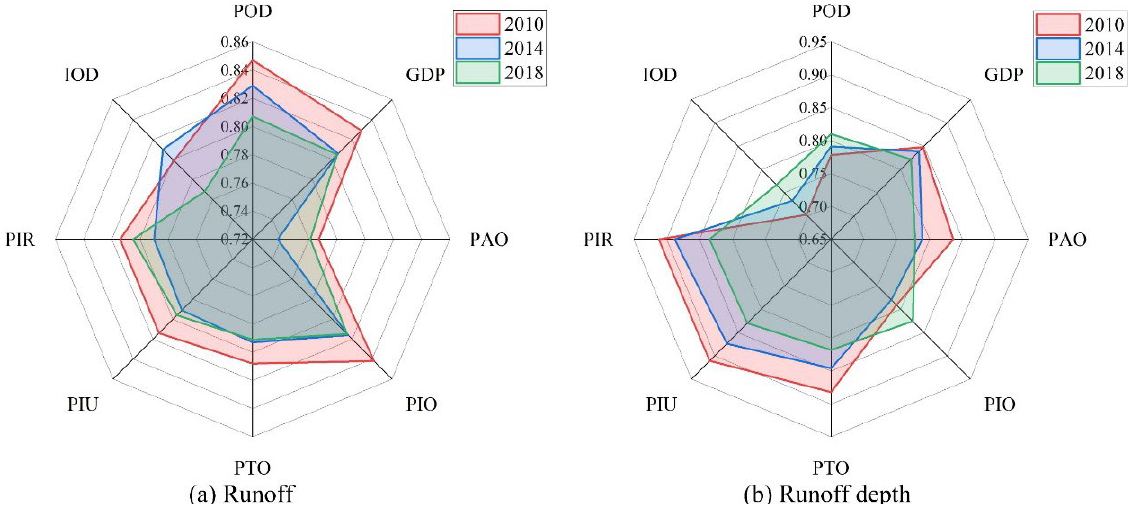
Figure 7. Correlation degrees between socioeconomic development indicators and runoff as well as runoff depth. Abbreviation: per capita gross domestic product (GDP, CNY), population density (POD, person/km 2 ), per capita agricultural output value (PAO, CNY), per capita industrial output value (PIO, CNY), per capita tertiary output value (PTO, CNY), per capita disposable income of urban residents (PIU, PIU), per capita disposable income of rural residents (PIR, CNY), industrial output density (IOD, CNY/m 2 ).